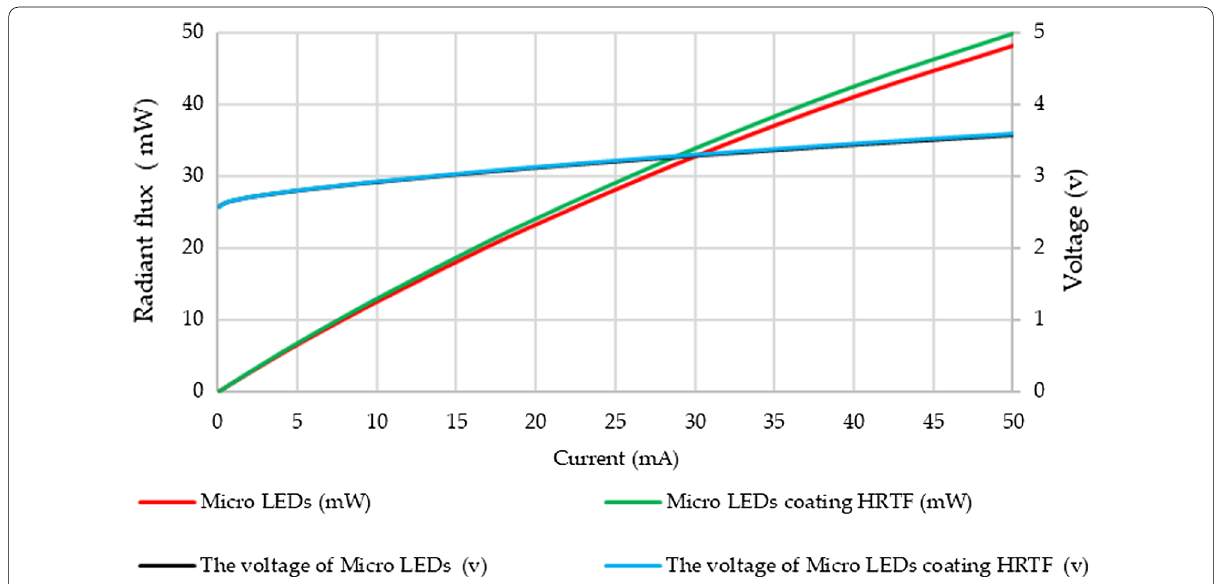
Fig. 9 Photoelectric characteristics of the micro‑LEDs without and with HRTF